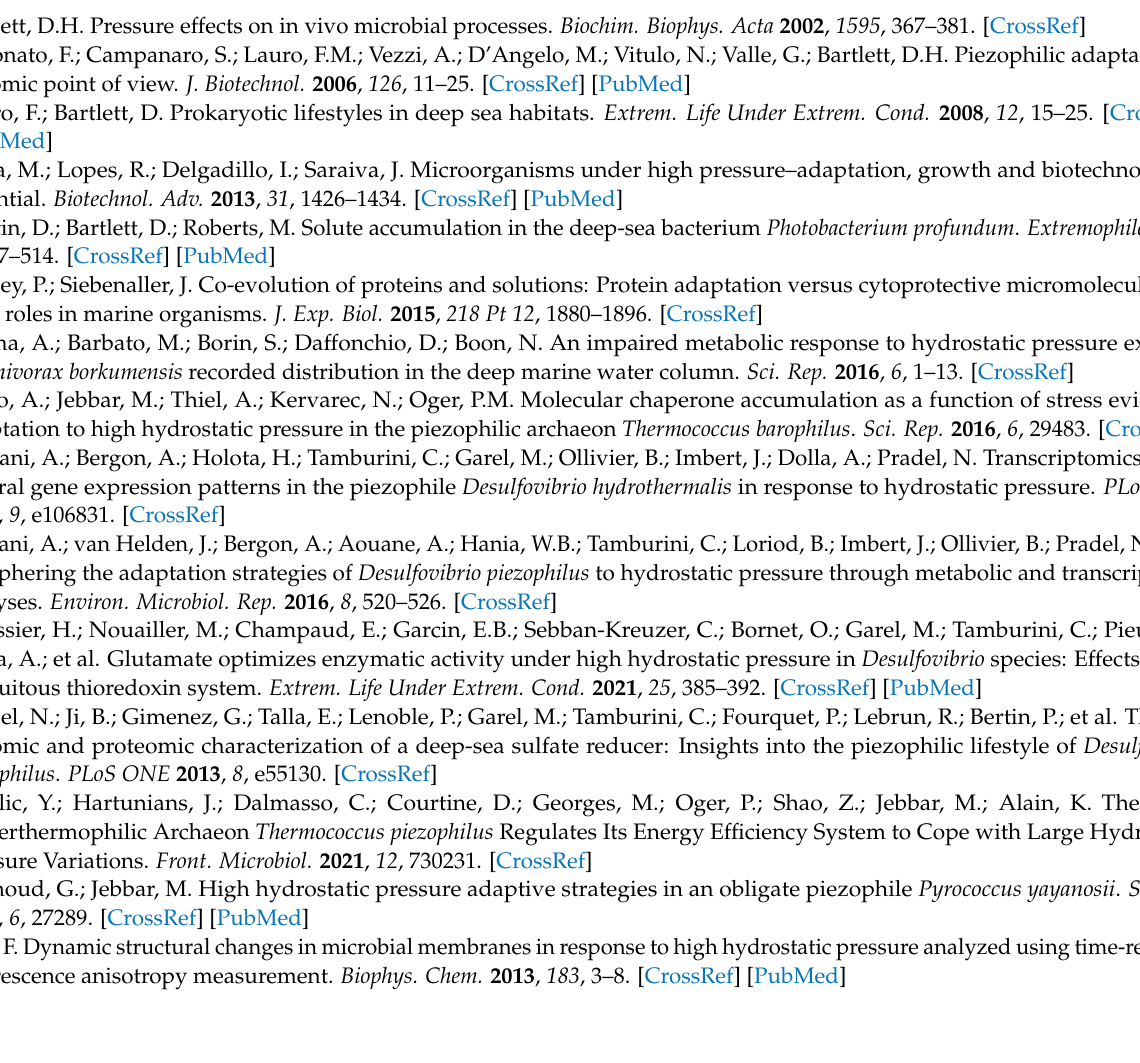
Table S3: List of differentially expressed genes in the deep strain P. elfii DSM9442 grown at 20 and 30 MPa vs. cells grown at 0.1 MPa; Table S4: List of differentially expressed genes in the surface strain P. elfii subsp. lettingae grown at 20 MPa vs. 0.1 MPa; Table S5: List of differentially expressed genes in the surface strain P. elfii subsp. lettingae that have differentially expressed orthologs in the deep strain P. elfii